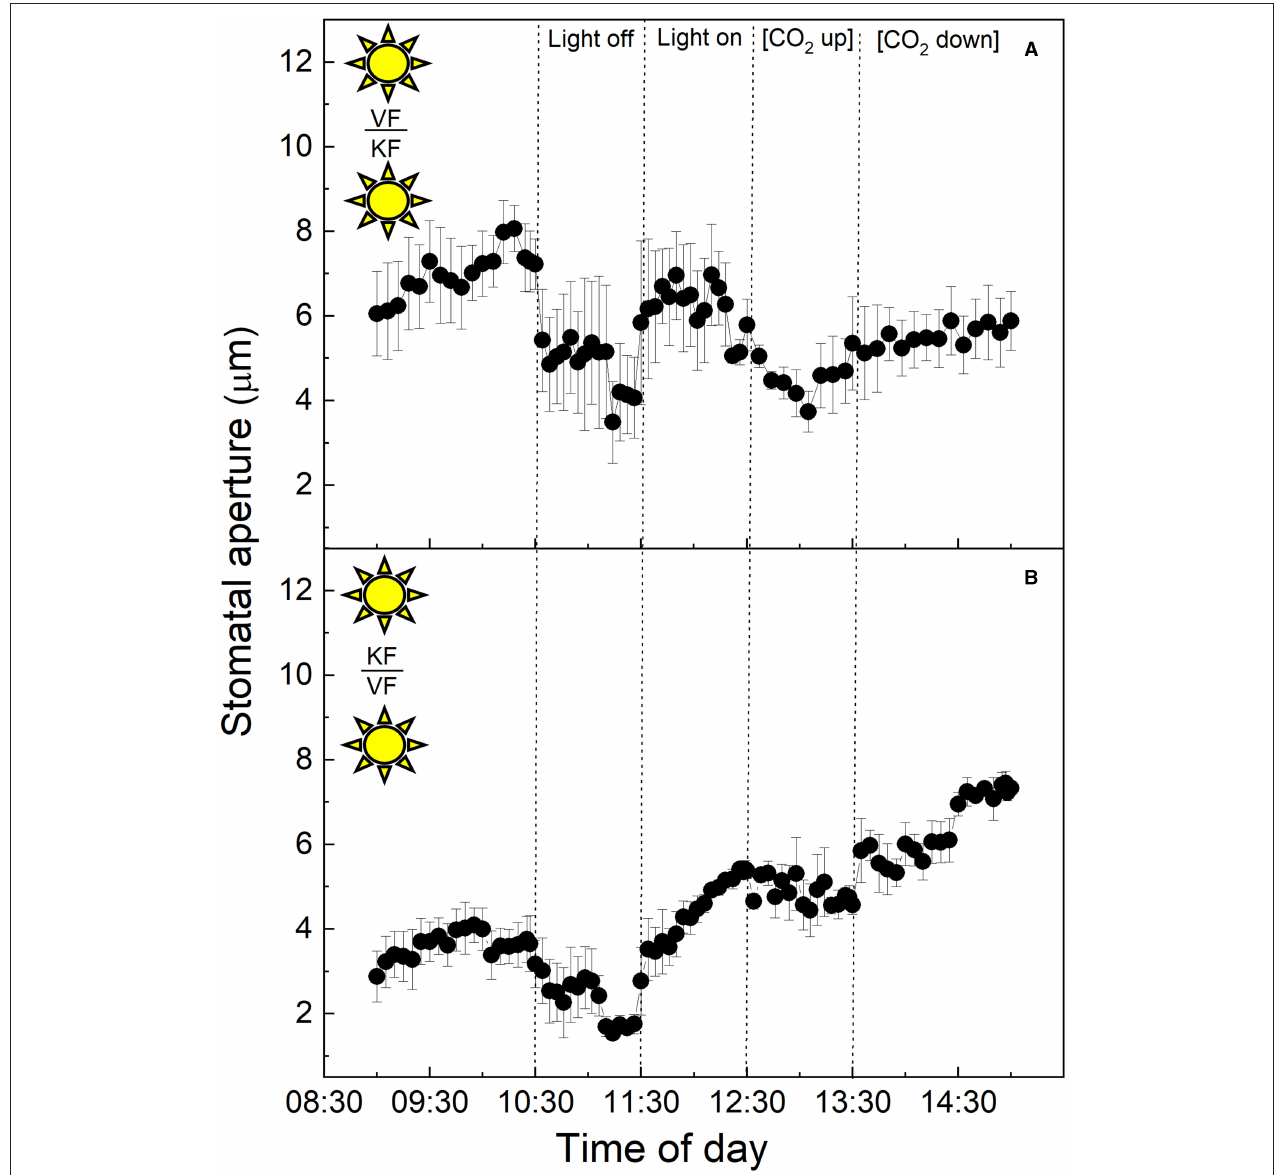
FIGURE 3 | (A) Abaxial peeled epidermis of Vicia faba leaf on abaxial exposed mesophyll of Kalanchoë fedschenkoi leaf from the “light” growth chamber; (B) Abaxial peeled epidermis of Kalanchoë fedschenkoi leaf on abaxial exposed mesophyll of Vicia faba leaf, from the “light” growth chamber (light period 8:00a.m. to 8:00 p.m.). Light intensity was changed from photon flux density of 400 ± 10 µ mol m − 2 s − 1 to darkness, as indicated, and [CO 2 ] was changed from 120 to 650 µ mol mol − 1 , as indicated. The temperature of the chamber was maintained at 23 ± 1 ◦ C. The values are means of four repetitions ( ± SE). The sun symbol represents plants taken from the light-grown